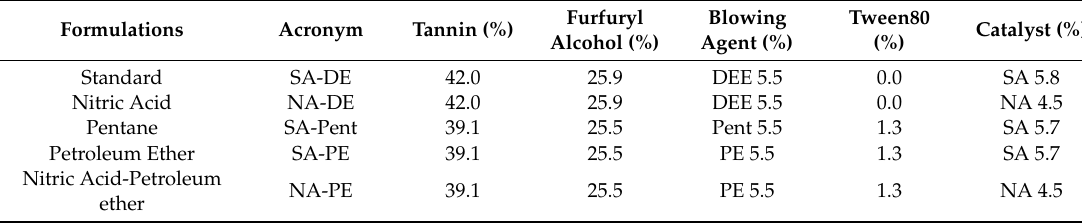
Table 1. Formulation description in percentage by